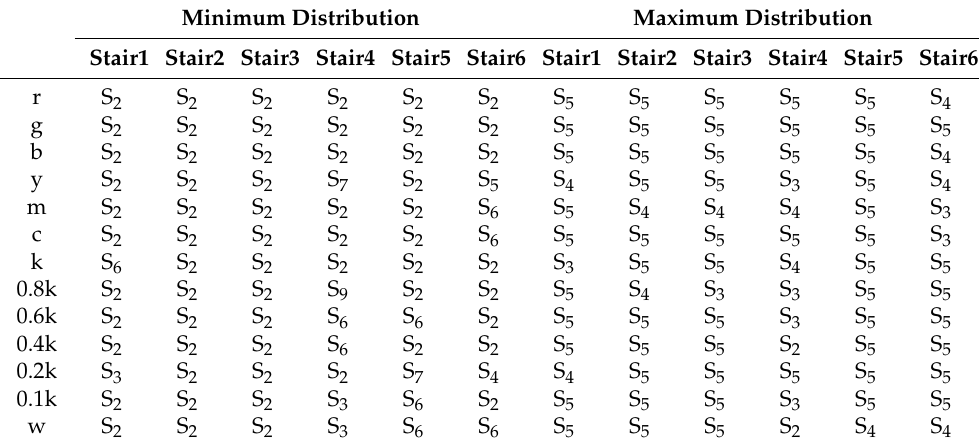
colors listed in Table 3, it is obvious that most of the color stairs in Sample 2 have the smallest average value of the color bars on them, followed by Sample 6. Except for Sample 2, the minimum values of the average color difference of the colored stairs were mainly distributed in the white bars and 0.2k bars. Meanwhile, most of the color stairs in Sample 5 have the largest average value of the color bars on them, followed by Sample 4 and Sample 3. From a statistical point of view, this also somewhat validates the same trend between color difference and the number of printed layers for each stair. Table 3. Distribution of extreme values of color difference for nine controlled